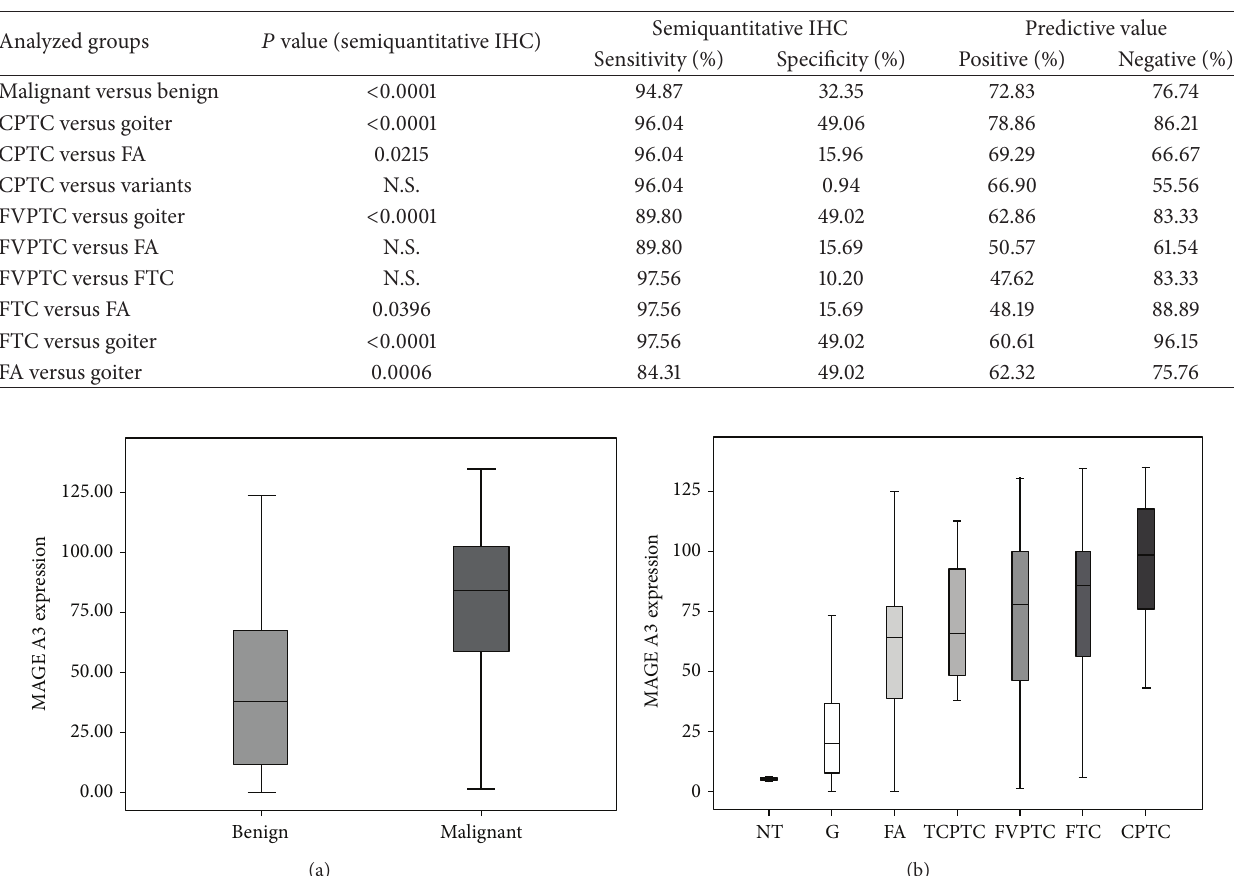
Table 1: MAGE A3 expression levels according to visual (semiquantitative) IHC in benign and malignant thyroid nodules and in different follicular patterned lesions including classic (CPTC), follicular variant papillary thyroid carcinomas (FVPT), follicular carcinoma (FTC), and follicular adenoma (FA).